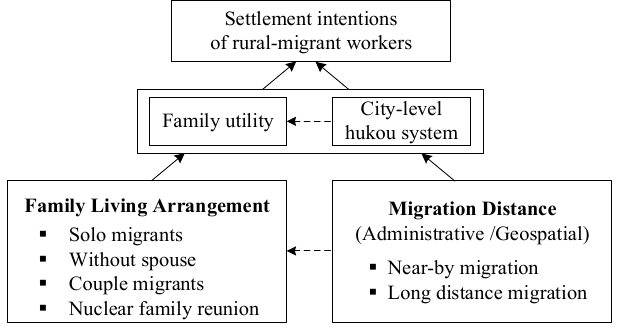
Figure 1. The study’s conceptual